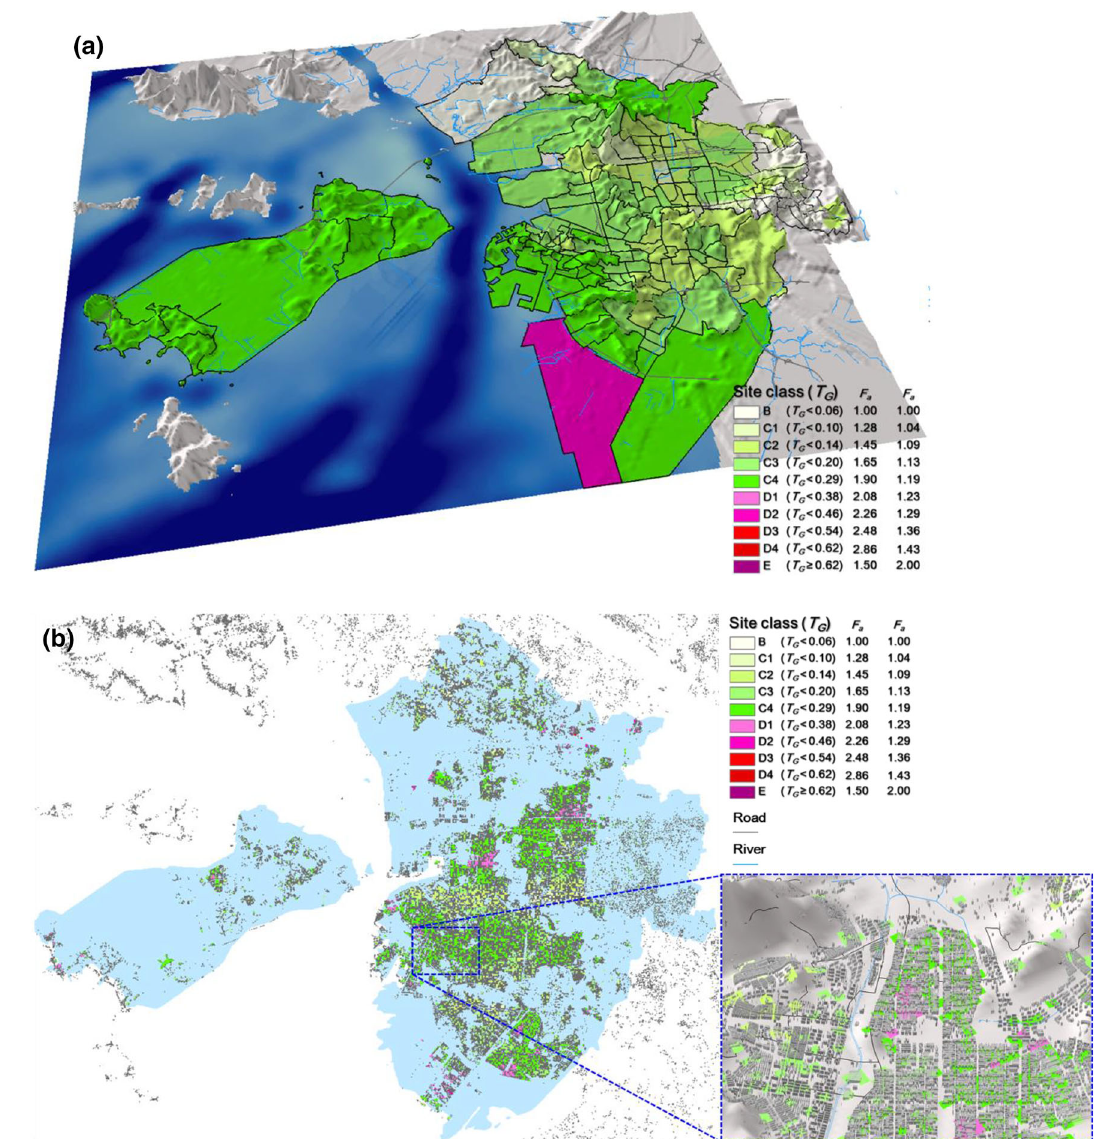
Fig. 11 The Incheon and Bucheon study areas in South Korea: Site class of administrative subunits by computing the average T G for each unit and the seismic fragility-based zonation in the Incheon and